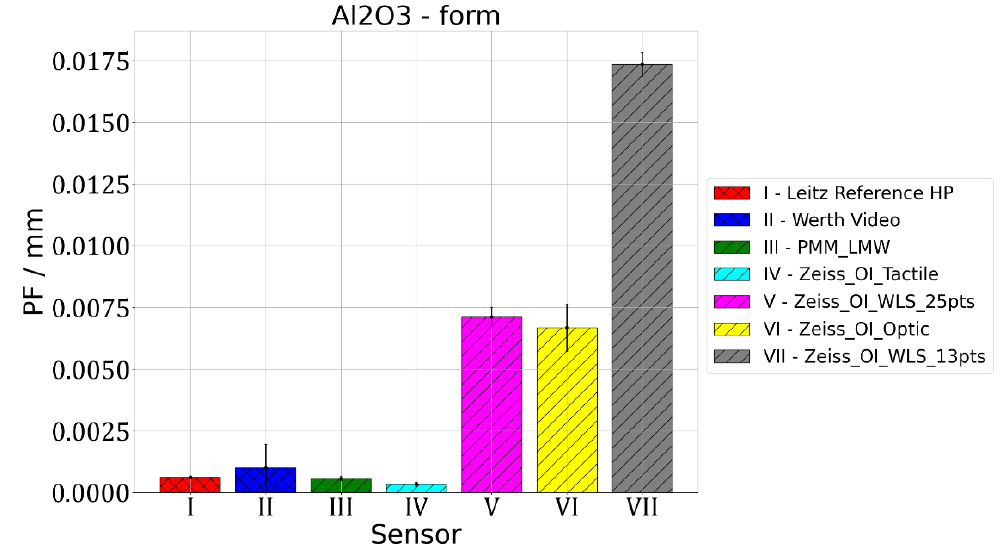
Figure 5. Results of measurements of PF parameter value for sphere made of alumina.